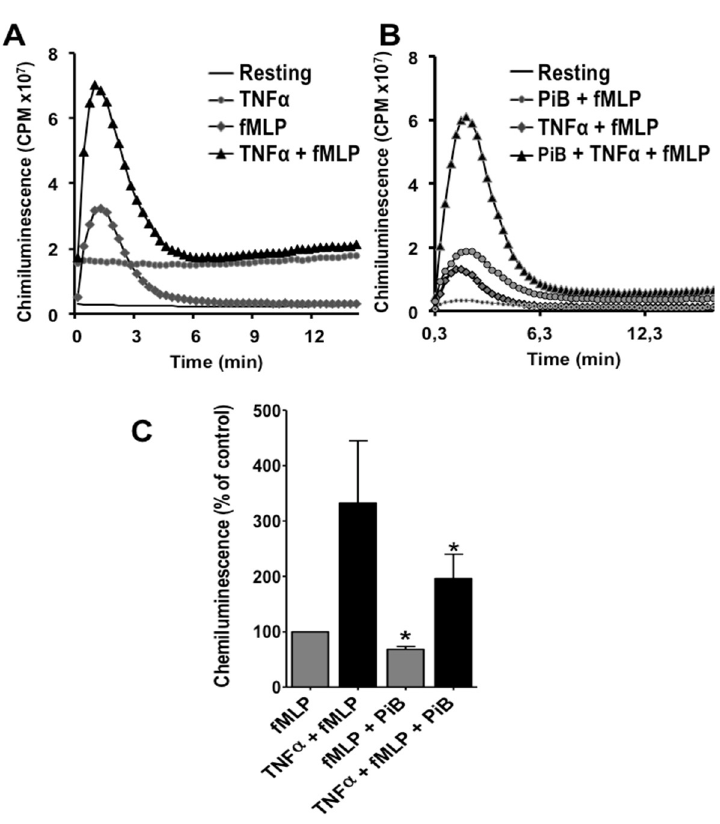
Figure 6. Effect of PiB on ROS production by human neutrophils. ( A ) Neutrophils (5 × 10 5 cells/0.5 mL) were incubated or not with TNF α (20 ng/mL) for 20 min before stimulation with fMLP (10 − 7 M). ROS productions were measured by luminol-enhanced chemiluminecence assay. This result represents an example of ROS production of resting or in the presence of TNF α , fMLP or TNF α + fMLP. ( B ) Neutrophils (5 × 10 5 cells/0.5 mL) were incubated or not with PiB (50 μ M) for 30 min, then treated or not with TNF α (20 ng/mL) for 20 min before stimulation with fMLP (10 − 7 M). ROS productions were measured with luminol-enhanced chemiluminecence assay. ( C ) Histograms representing ROS production as calculated by the mean of the total area under the chemiluminescence curves. Data are means ± S.E.M. of 3 separate experiments (* p < 0.05).